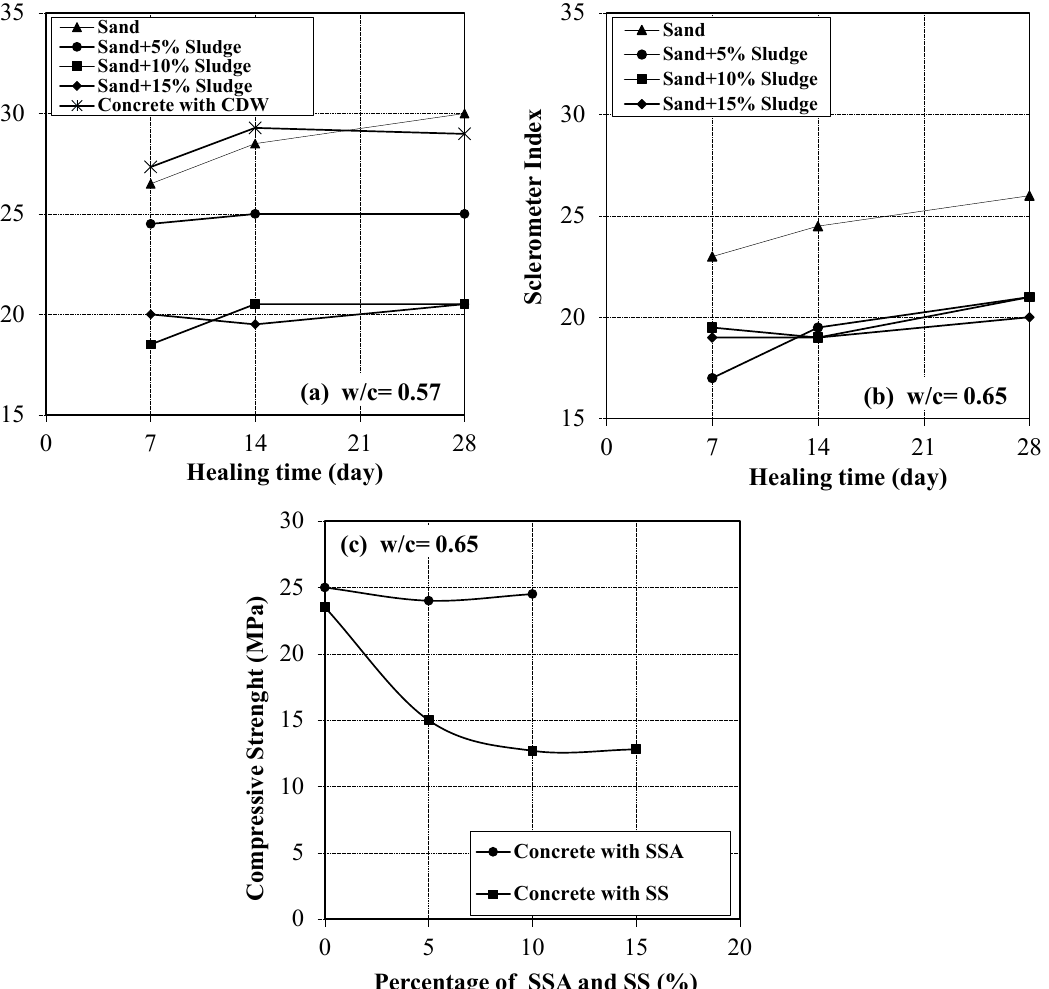
Figure 8. Compressive strength versus healing time: ( a ) conventional concrete, with sewage sludge and with CDW [27], w/c = 0.57; ( b ) conventional concrete with sewage sludge, w/c = 0.65.; and ( c ) concrete with sewage sludge (SS) and sewage sludge ash (SSA) [23], w/c = 0.65.